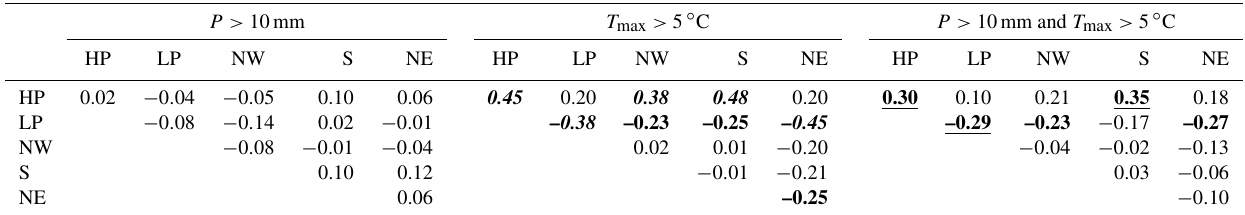
Figure 8. DJF change in CRCM5-LE average percentage of days with precipitation and warm events relative to DJF occurrence of weather regimes between the historical (1961–1990) and the future period (2026–2055). The dotted lines represent the standard deviation of the 50-member CRCM5-LE simulated change. Table 1. Inter-member correlations between DJF change in occurrence of weather regimes and DJF change in number of events between 1961–1990 and 2026–2055. Bold text shows correlation significance at the 90% confidence level, underlined text shows correlation signifi- cance at 95%, and italic text shows correlation significance at 99% according to the Pearson correlation table.